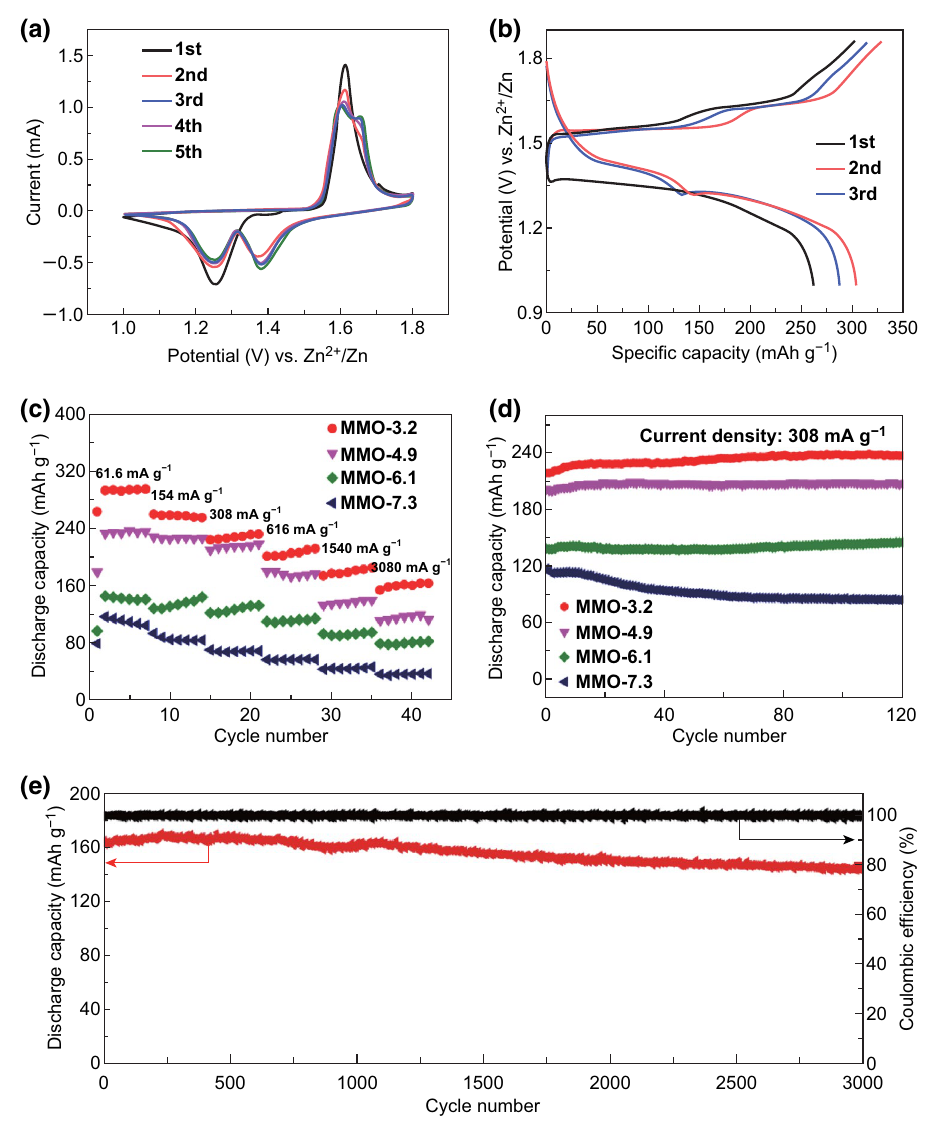
Fig. 4 Electrochemical performances of Zn/Mn 2 O 3 batteries. a Cyclic voltammetry curve of MMO‑3.2 at 0.1 mV s −1 . b Galvanostatic charge– discharge curve of MMO‑3.2. c Rate capability and d cycling performance of Mn 2 O 3 electrodes with different surface areas in hybrid electrolyte (2 M ZnSO 4 + 0.2 M MnSO 4 ). e Long‑term cycling stability of MMO‑3.2 at 3080 mA g